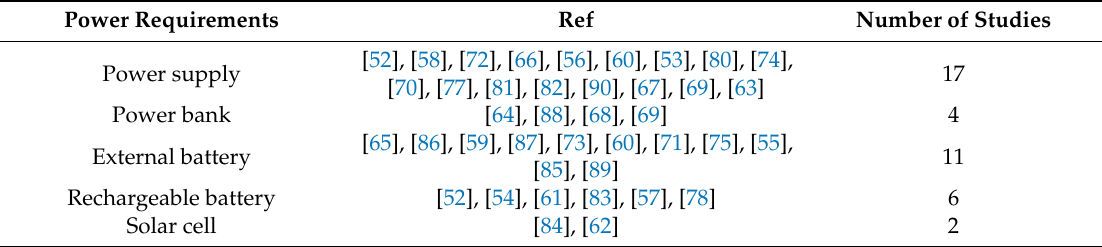
Table 9. Preferred sources of power to run IAQ monitoring